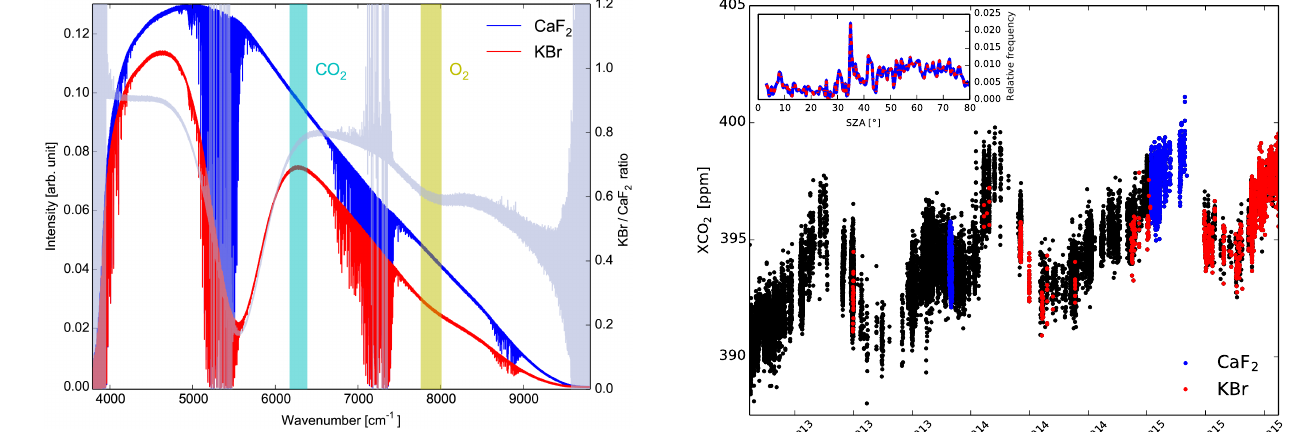
Figure 1. Spectra of a near-infrared (NIR) lamp measured with KBr (red) and CaF 2 (blue) beam splitters; the spectral regions where the CO 2 and O 2 target gases are retrieved are shown in cyan and yellow, respectively. The KBr / CaF 2 lamp intensity ratio, as shown in gray, is smooth at the target regions and is lower for O 2 (the gas which presents larger error differences among beam splitters).